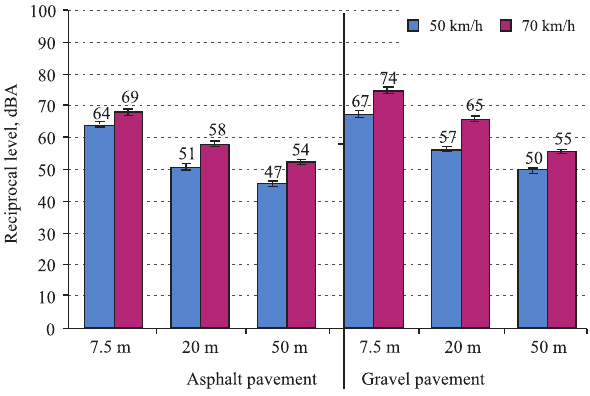
Fig. 10. Dependence of reciprocal noise levels on car speed when driving in an open area on roads with diff erent pavements in